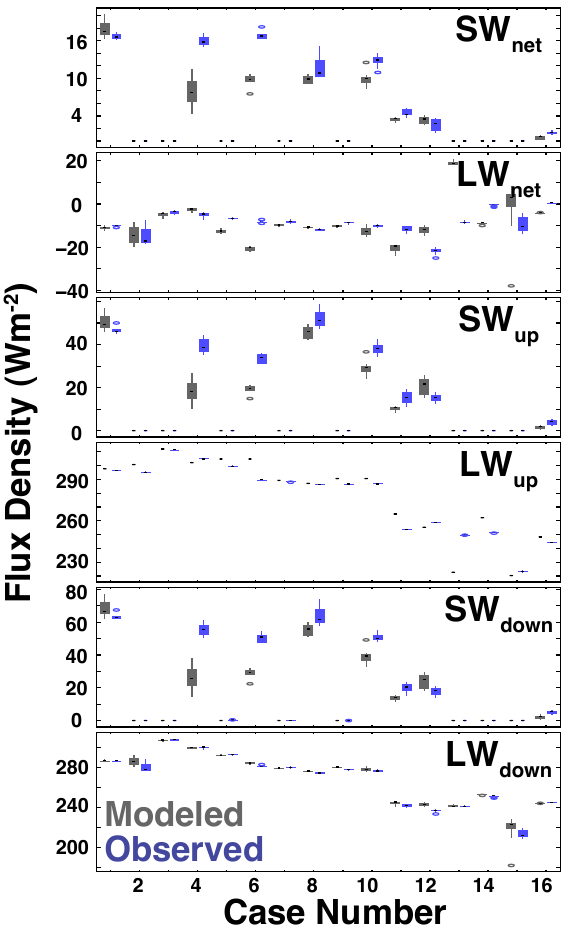
Fig. 3. Distributions of modeled (grey) and measured (blue) surface radiative flux densities. From top to bottom: net shortwave (SW net ), net longwave (LW net ), upward shortwave (SW up ), upward longwave (LW up ), downward shortwave (SW down ), and downward longwave (LW down ). The dots represent the case mean, the thick bar the 25th/75th percentiles, and the whiskers representing 1.5xIQR beyond 25th and 75th percentiles. Any values outside of that range are indicated by open circles.